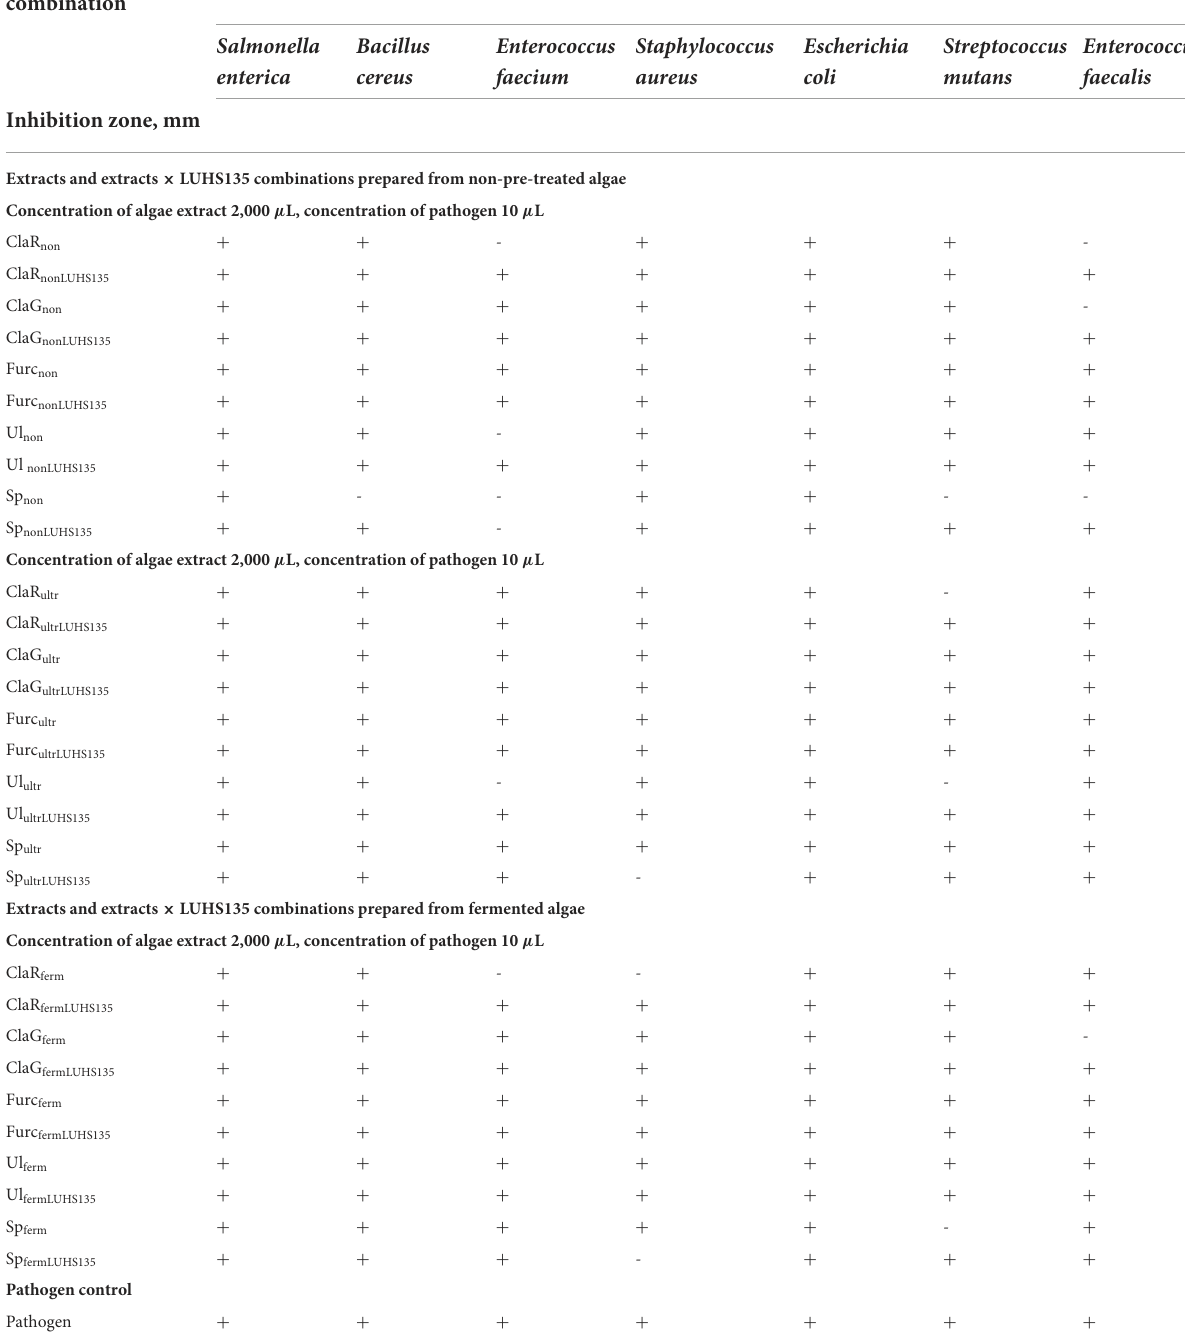
TABLE 6 Antimicrobial activity of the algae extracts and algae extracts × LUHS135 combinations evaluated in liquid medium by testing the concentration of algae extract and/or algae extract × LUHS135 combination at a concentration of 2,000 µ L and pathogen concentration at 10 µ L. Extracts and extract × LUHS135 combination